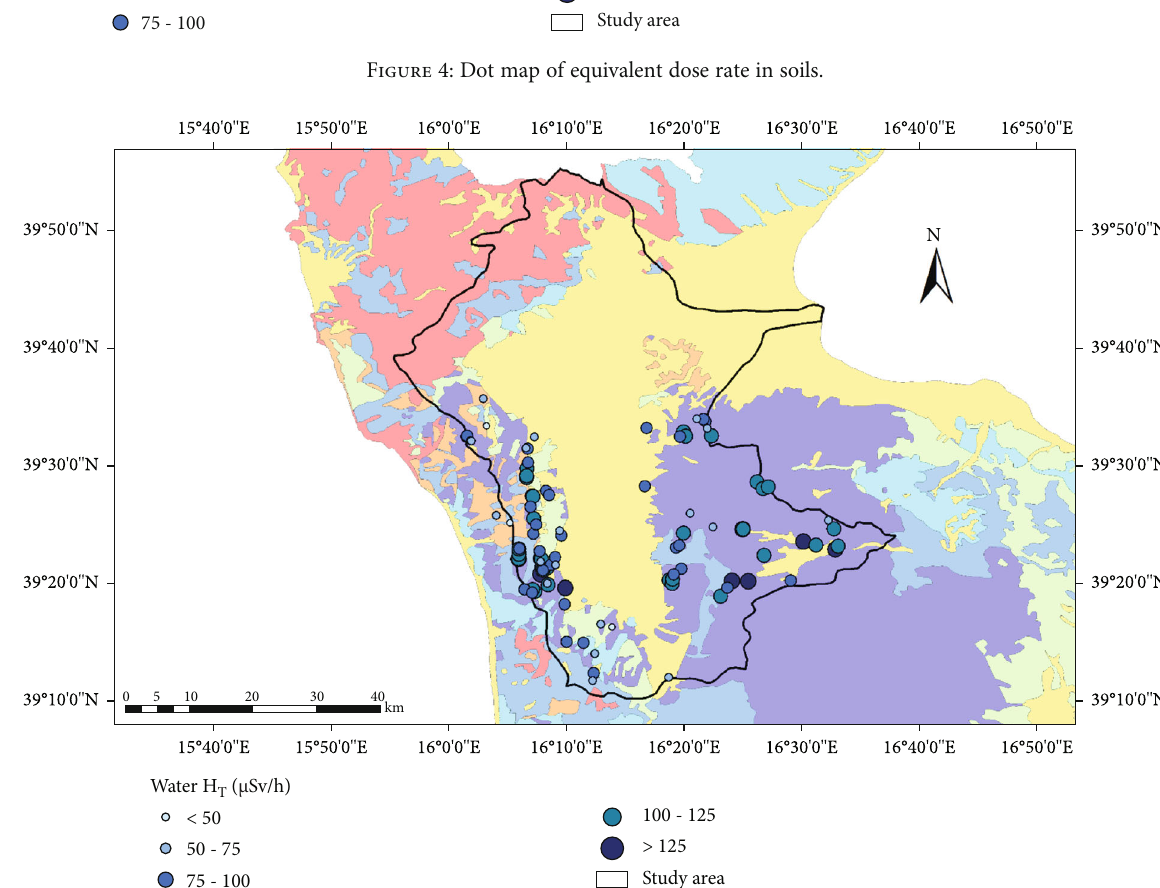
Figure 5: Dot map of equivalent dose rate in